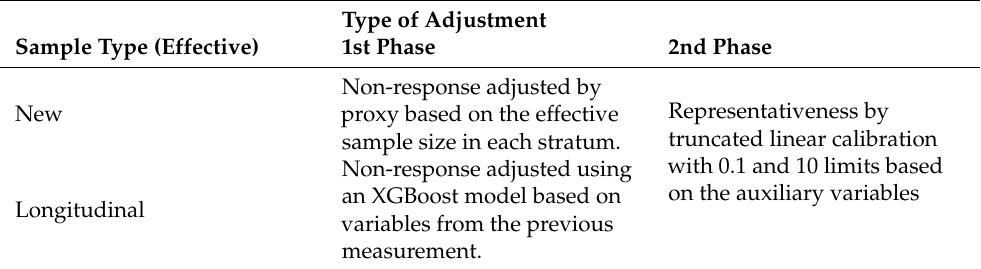
Table 3. Health Care and Social Survey (ESSOC): Adjustment of the design sampling weight in each